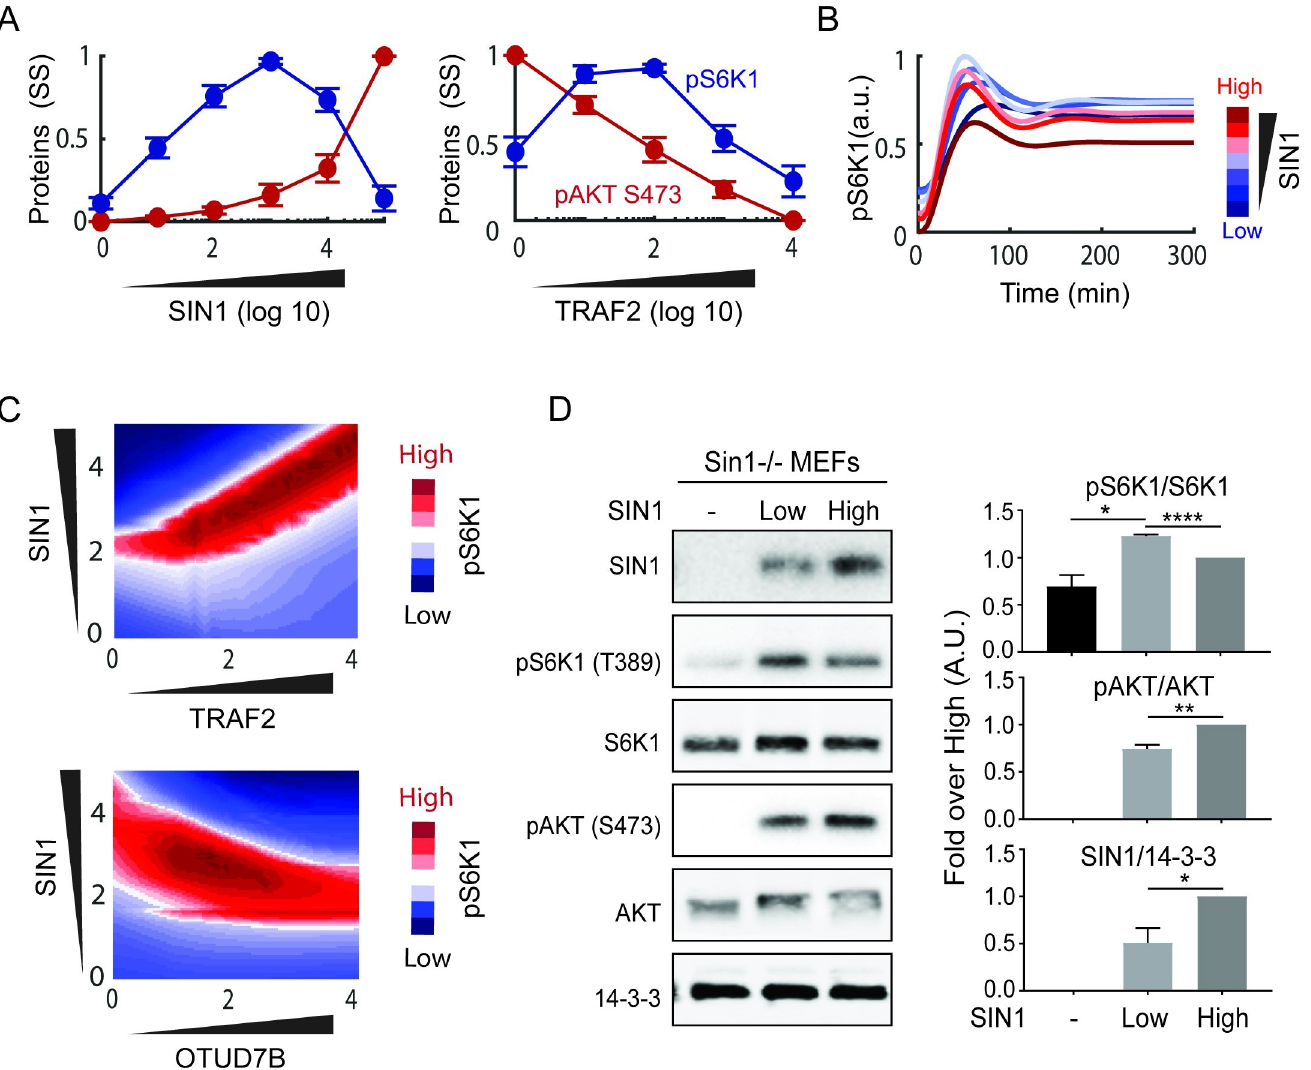
Fig 4. In silico analyses and experimental validation show biphasic dependency of mTORC1 activity on SIN1. (A) Dose-response simulations of the steady-state values of pS6K1 and pAKT S473 in response to increasing SIN1 or TRAF2, revealing a biphasic dependence of mTORC1 activity on SIN1. SIN1 or TRAF2 concentrations were varied within a wide range: 100 folds down and 1000 folds up of their nominal values. Each curve related to each parameter set was normalized by its maximal (peak) value and then average and S.E.M. were calculated at each concentration. (B) Temporal simulations of pS6K1 at different concentrations of SIN1. (C) Two-dimensional perturbation analysis showing the simulated steady-state response of pS6K1 to simultaneous change in pairs of proteins, which demonstrates the biphasic pattern is robust over wide ranges of TRAF2 and OTUD7B expression levels. (D) Experimental validation of the SIN1-mTORC1 biphasic dependency. Cells were deprived of serum for 2 h, followed by insulin (100 nM) stimulation for 10 min, and samples were analyzed by Western blot. Graphs show mean ± S.E.M. of quantitative analyses of Western blots ( � P < 0.05, �� P < 0.01, ���� P < 0.0001, two-tailed student’s t test, n = 3 biological replicates).